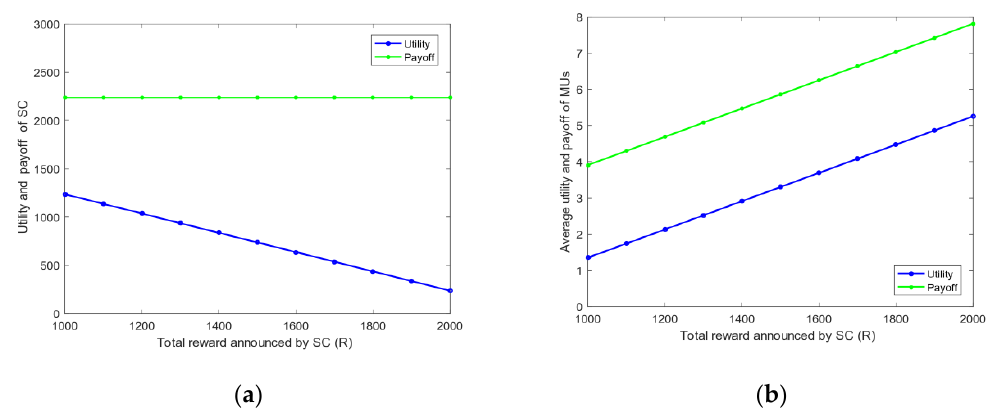
Figure 9. ( a ) Change in server center (SC) utility and payoff with total reward R ; ( b ) change in average utility and payoff of MUs with total reward R